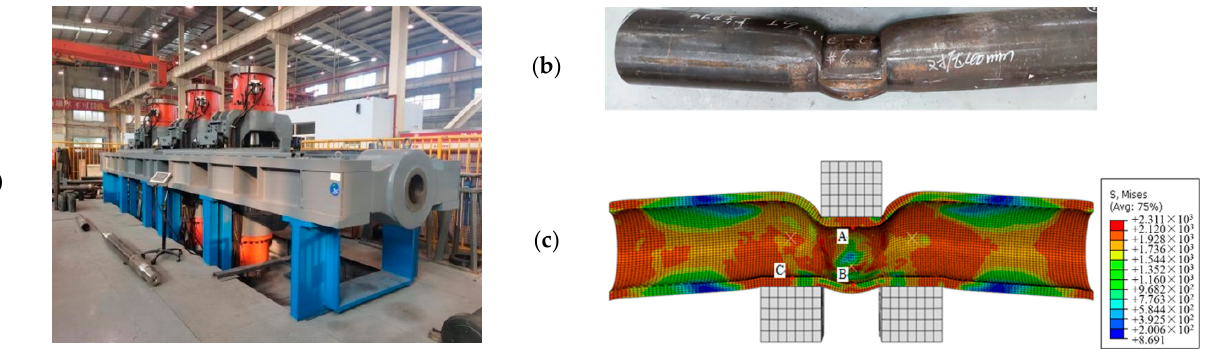
Figure 8. Casing deformation morphology after 40 mm shear deformation: ( a ) test equipment; ( b ) test morphology; ( c ) equivalent stress distribution diagram of finite element simulation.